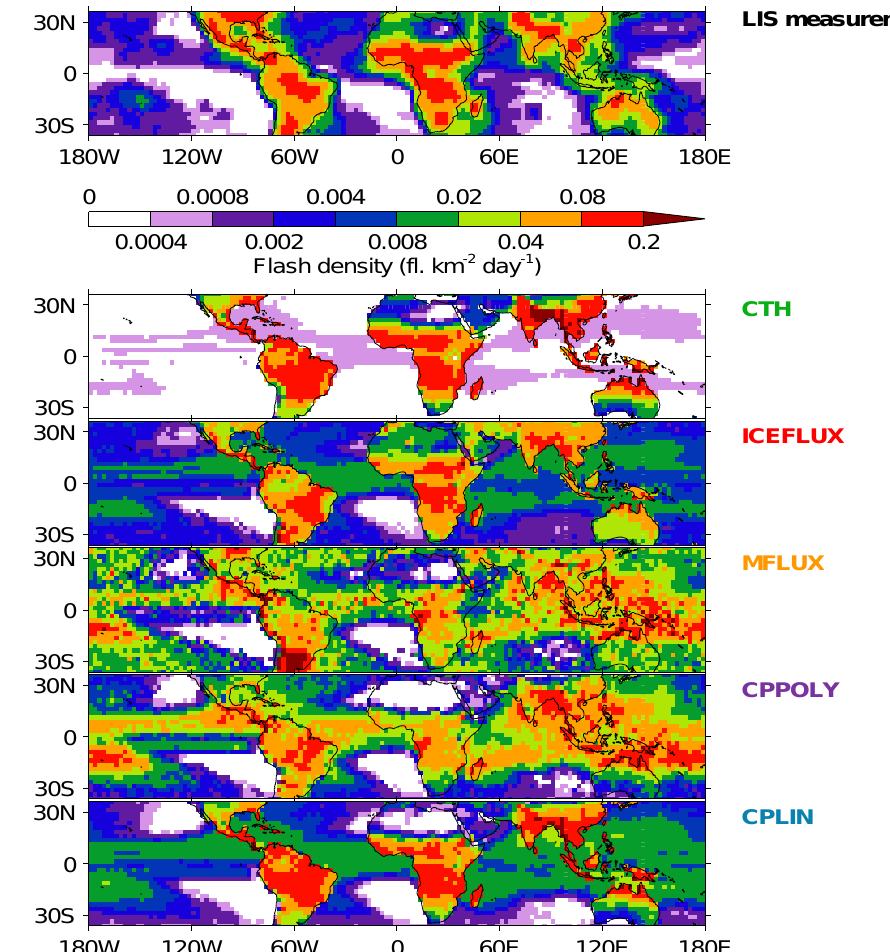
Figure 9. Five-year climatological seasonal peak-to-peak difference spatial distribution of flash density for 2007–2011. The seasonal peak- to-peak difference is the difference between the minimum monthly value and the maximum monthly value. Results are shown for the LIS measurements and the five